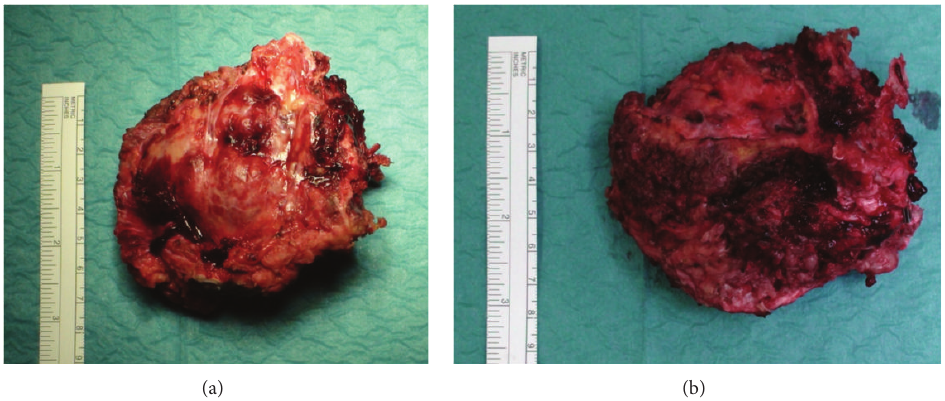
Figure 11: En bloc resected specimen. (a) Ventral surface and (b) dorsal